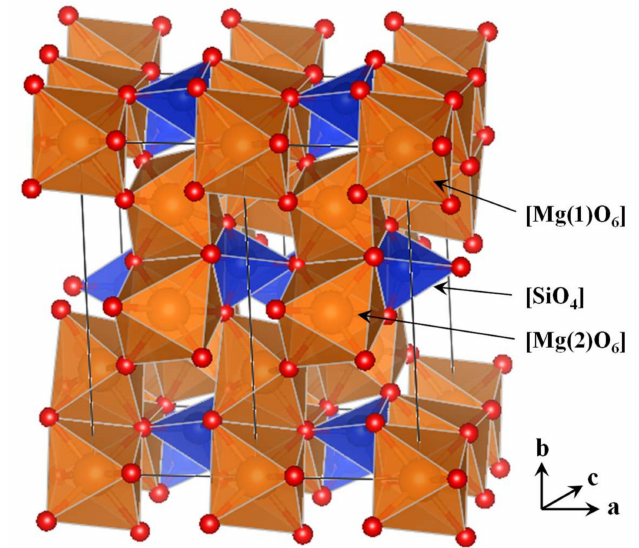
Figure 1. View (along the c crystallographic axis) of the crystal structure of forsterite. The two symmetry-independent Mg atoms are indicated according to the octahedral units [Mg(1)O 6 ] and [Mg(2)O 6 ] (in brown). The tetrahedral [SiO 4 ] unit blocks (in blue) are also indicated. O atoms are shown in